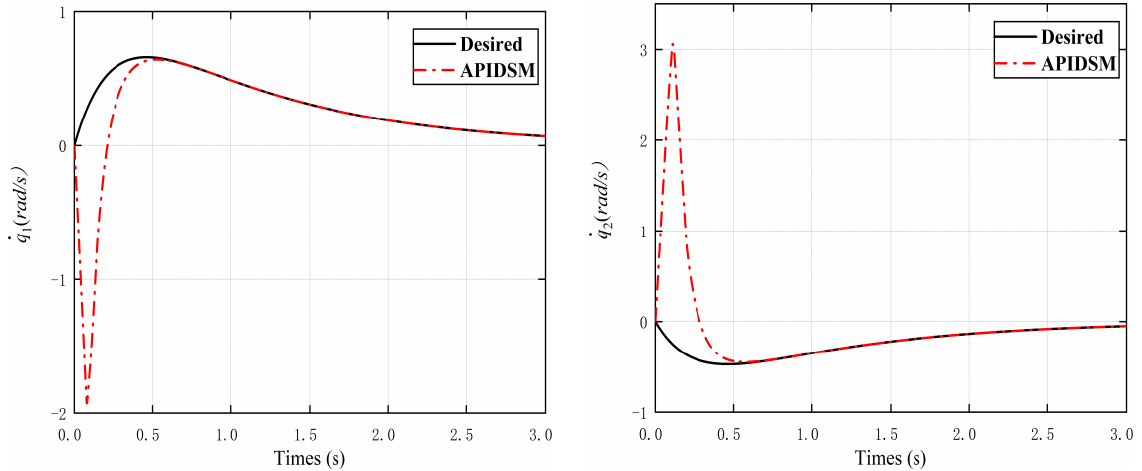
Figure 5. Velocity tracking results of Joint 1 and Joint 2.